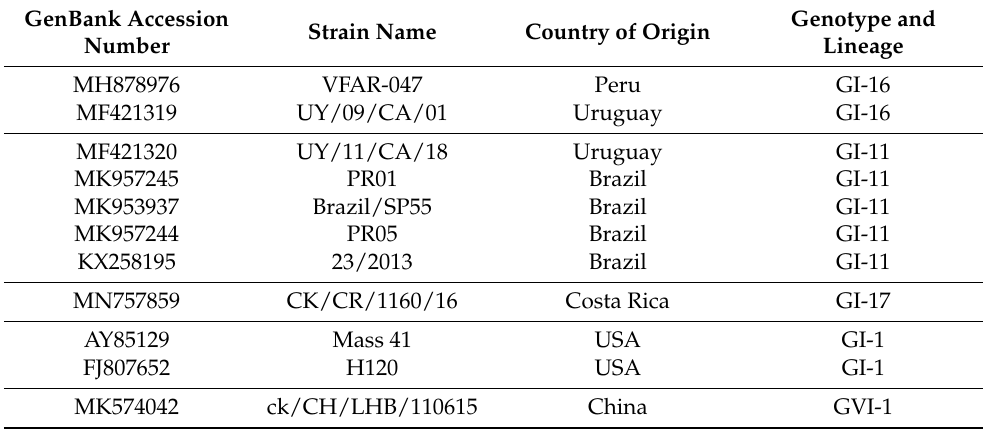
Table 2. Reference sequences available in Genbank used as putative parental